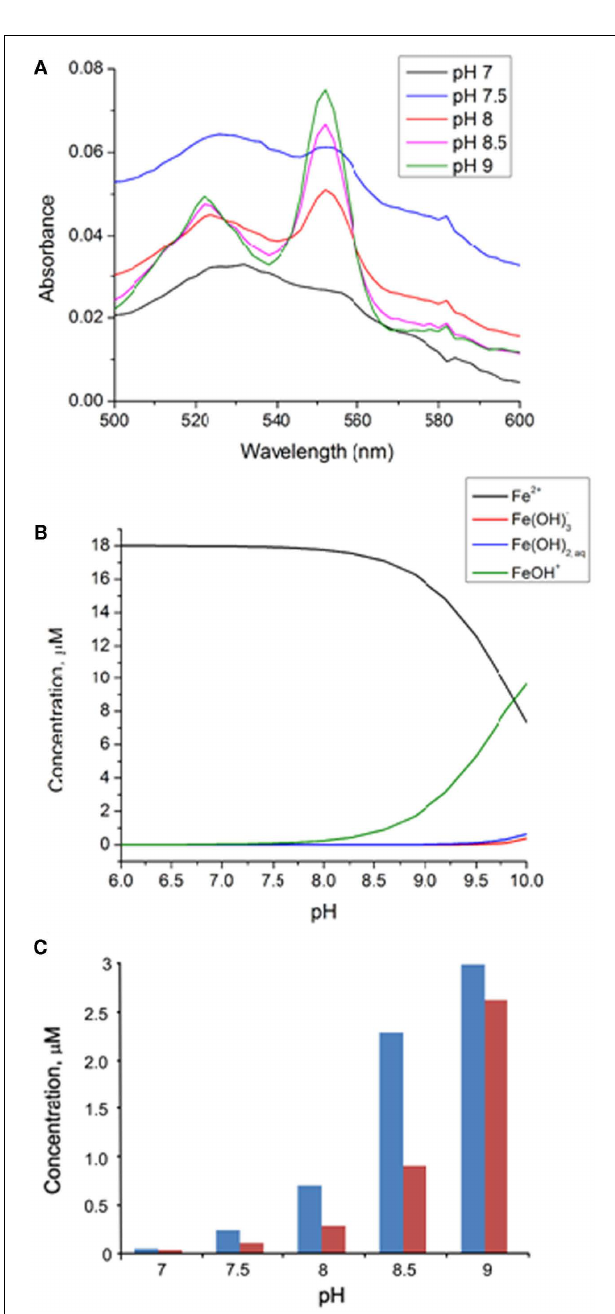
FIGURE 7 | (A) Absorption spectra of MtoA (0.4 μ M) after the oxidation of 18 μ M FeCl 2 at pH 7 (black), pH 7.5 (blue), pH 8 (red), pH 8.5 (pink), and pH 9 (green). (B) Speciation of Fe(II; 18 μ M) as a function of pH in 150mM NaCl solution (Allison et al., 1991). (C) Variation of Fe(II; blue columns) oxidized by MtoA at the end of reactions and initial [Fe(OH) + ] (red columns) as a function of pH.